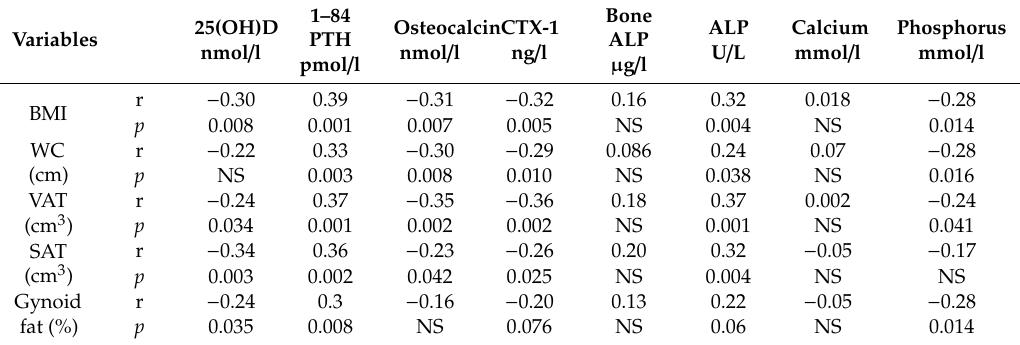
Table 3. Spearman correlation between body fat measures and metabolic markers.